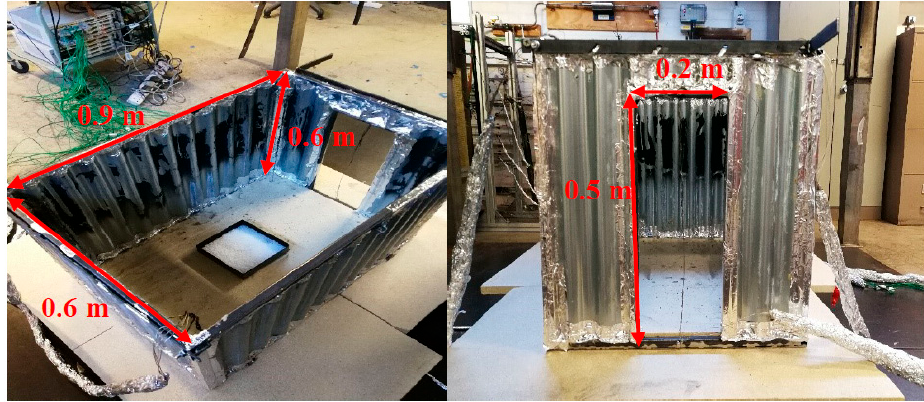
Figure 6. Quarter scale ISO-9705 compartment (open roof for demonstration) [9].